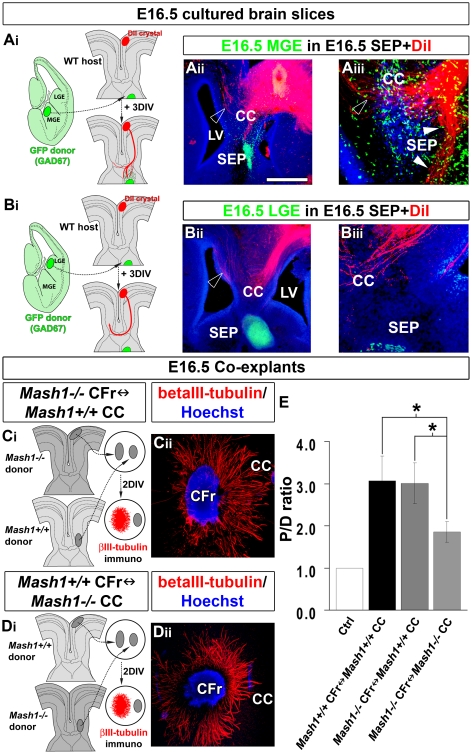
GABAergic interneurons exert part of the attractive influence on callosal axons.(Ai) Experimental paradigm used to determine whether CC GABAergic interneurons attract callosal axons. To test this hypothesis, we placed a small explant of E16.5 medial ganglionic eminence (MGE) that generates the CC GABAergic interneurons into the SEP of an E16.5 slice. (Aii–Aiii) DiI staining showing that numerous callosal axons penetrate through the SEP and are attracted by GAD67-GFP+ migrating GABAergic interneurons derived from the MGE explant. (Bi) As a control, E16.5 GAD67-GFP+ lateral ganglionic eminence (LGE) explant that does not generate CC GABAergic interneurons is transplanted into the SEP of an E16.5 slice. (Bii–Biii) LGE explant does not attract callosal axons through the nonpermissive septal region. Open arrowhead in (Aii and Bii) highlights callosal axons crossing the midline of the CC, whereas arrowheads in (Aiii) indicate callosal axons that are misrouted within the SEP. Brain slices in (Aii, Aiii, Bii, and Biii) were counterstained with Hoechst. (Ci) Experimental paradigm used to analyze whether Mash1−/− cortical axons respond normally to CC attraction. (Cii) Immunohistochemical staining for βIII-tubulin on E16.5 Mash1−/− frontal cortex (CFr) cocultured with E16.5 Mash1+/+ CC. (Di) Experimental paradigm used to analyze whether CC GABAergic interneurons promote cortical axons attraction. For this, WT CFr explants were cocultured with small explants of Mash1−/− CC missing GABAergic interneurons (Dii) Immunohistochemical staining for βIII-tubulin on E16.5 Mash1+/+ frontal cortex cocultured with E16.5 Mash1−/− CC. (E) Quantification of the axonal guidance responses to CC explants. Data are expressed as a P/D ratio ±SEM, where P and D are the mean fluorescence intensity in the quadrants proximal and distal to Mash1+/+ or Mash1−/− CC explants. An asterisk (*) indicates significantly different with p<0.05. Mash1−/− cortical axons are normally attracted by WT CC. By contrast, Mash1 mutant CC is still attractive for cortical axons, but with a reduced efficiency compare to WT CC. Bar indicates 485 µm in (Aii, Bii, Cii, and Dii) and 120 µm in (Aiii and Biii). LV, lateral ventricle.